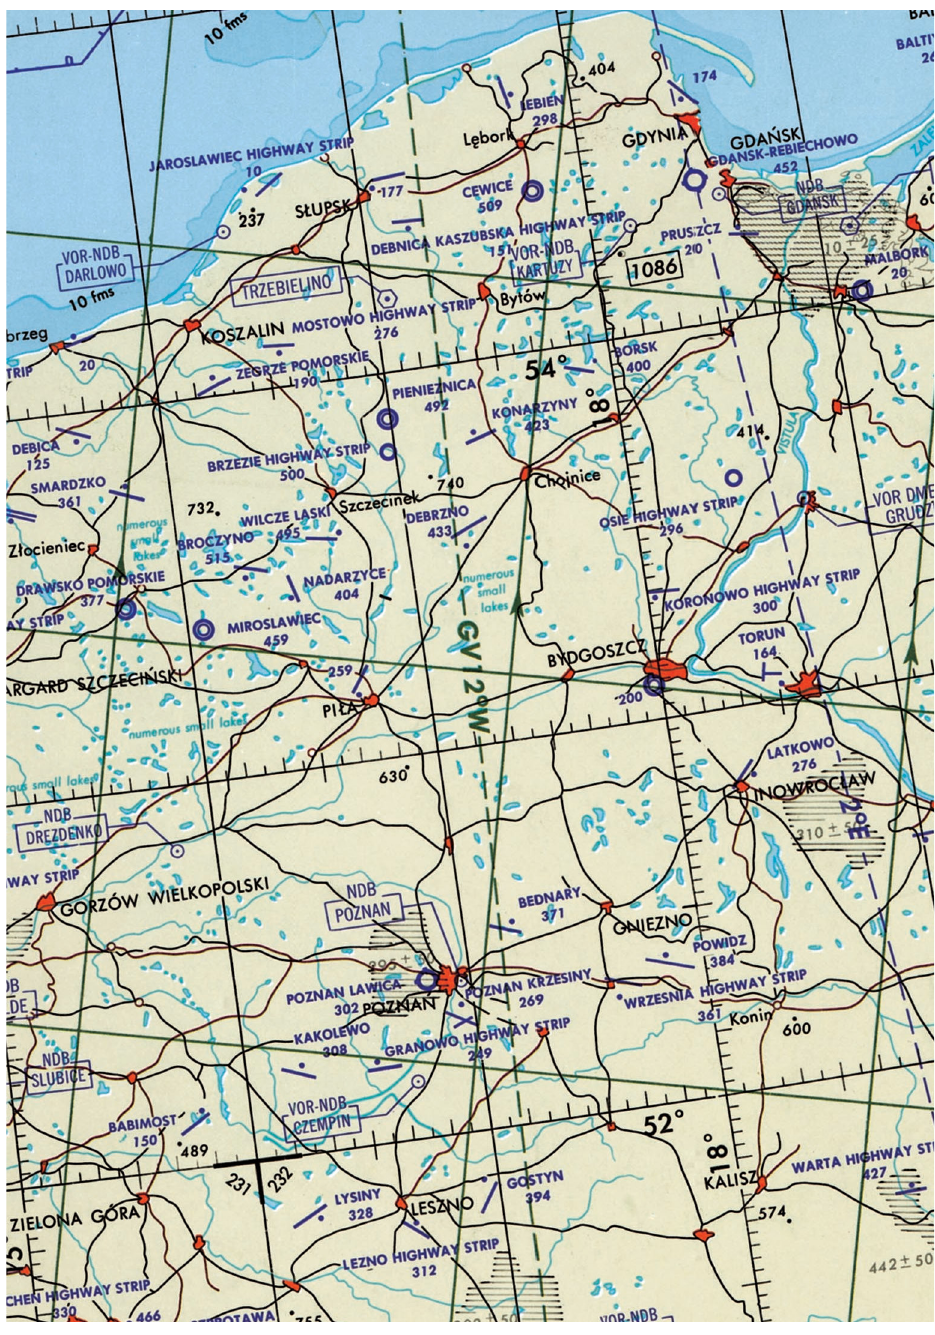
Fig. 15. Jet Navigational Chart , 1:2,000,000 – JNC